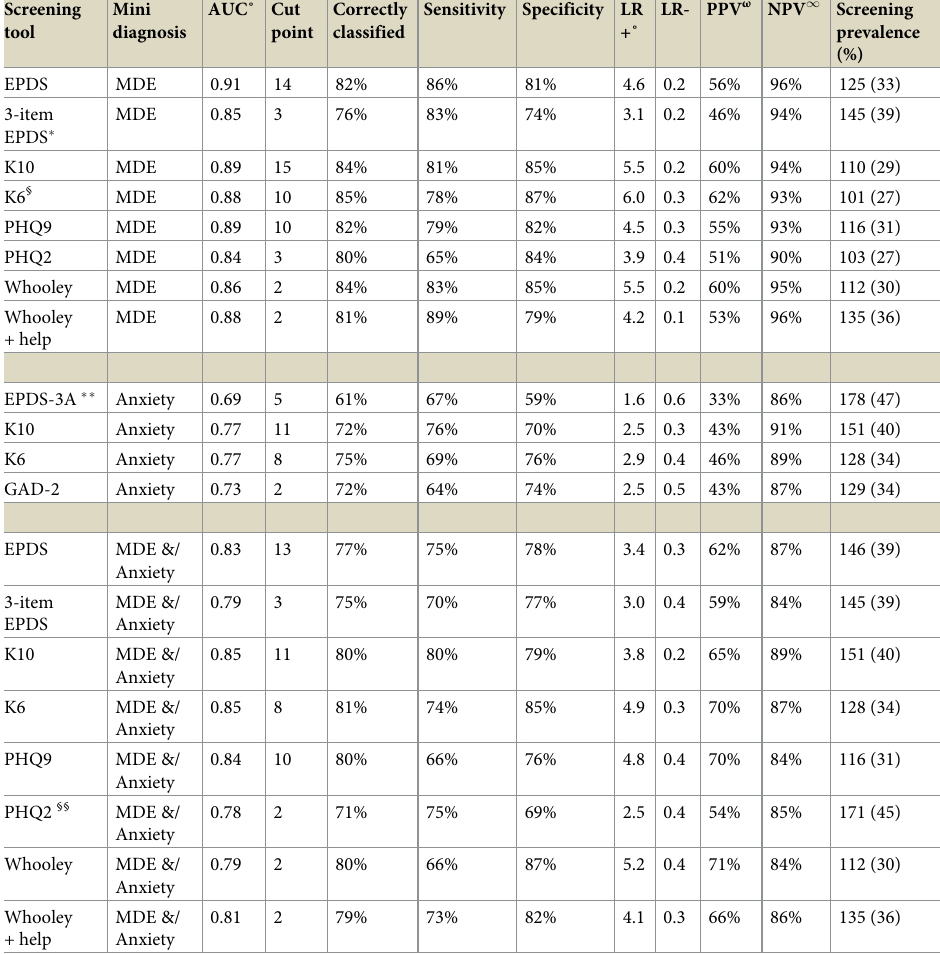
Table 4. Comparison of the performance of screening instruments against MINI defined MDE and anxiety diagnoses. Screening